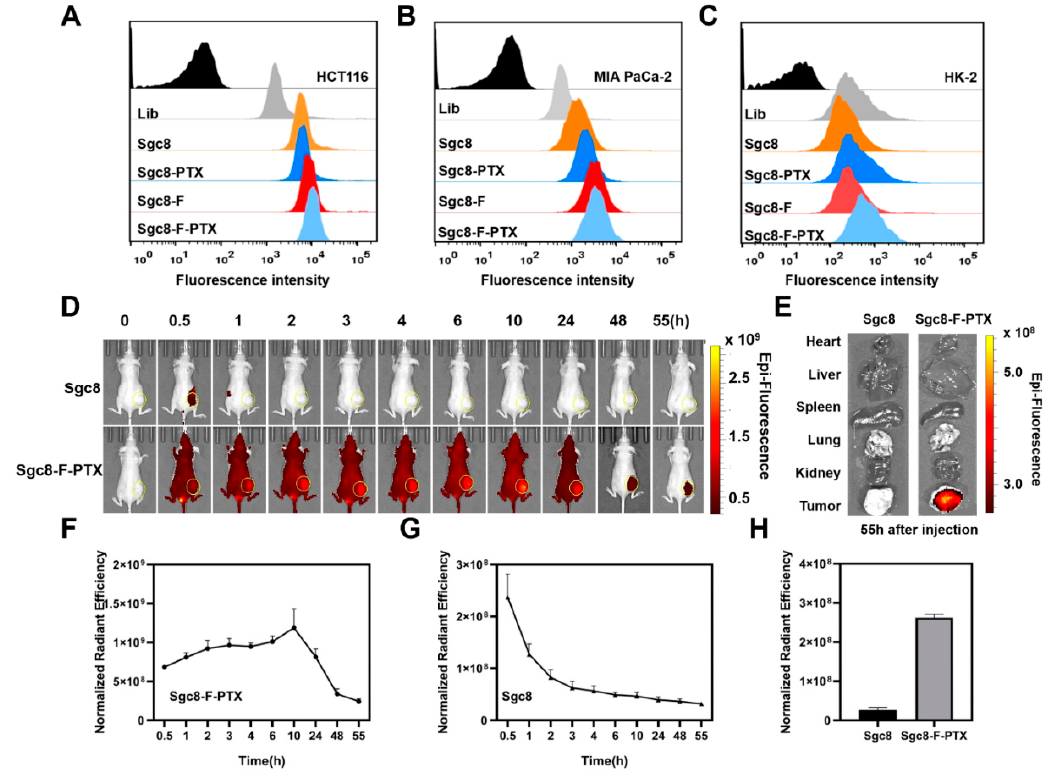
Figure 3. ( A – C ) Targeting effect of ApDC on the target cells ( A , HCT116, and B , MIA PaCa-2) and control cells ( C , HK-2) was analyzed with flow cytometry. Cells were incubated with 250 nM cy5-labeled oligonucleotides at 4 °C for 30 min. ( D ) In vivo fluorescence imaging of MIA PaCa-2 tumor-bearing mice after cy5-labeled Sgc8 or Sgc8-F-PTX were injected intravenously. The tumor sites are marked with yellow circles. ( E ) Ex vivo imaging of the main organs including heart, liver, spleen, lung, and kidney at 55 h post-injection. ( F ) The in vivo average radiant efficiency in tumor sites at different time points after cy5-labeled Sgc8 was injected intravenously, n = 3. ( G ) The in vivo average radiant efficiency in tumor sites at different time points after cy5-labeled Sgc8-F-PTX was injected intravenously, n = 3. ( H ) The quantitative result of the ex vivo fluorescence intensity in tumor site, n =